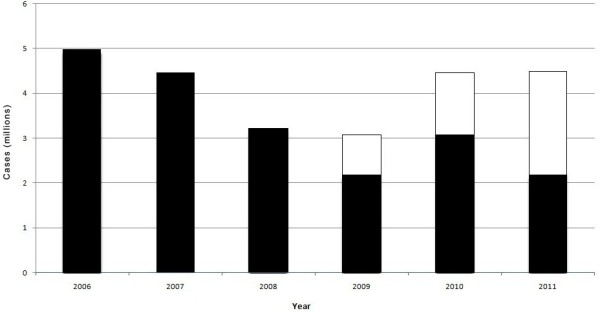
Trends in malaria cases and method of diagnosis in Zambia, 2006 to 2011. (Black bars indicate clinical cases, open bars indicate cases confirmed by microscopy or RDT).